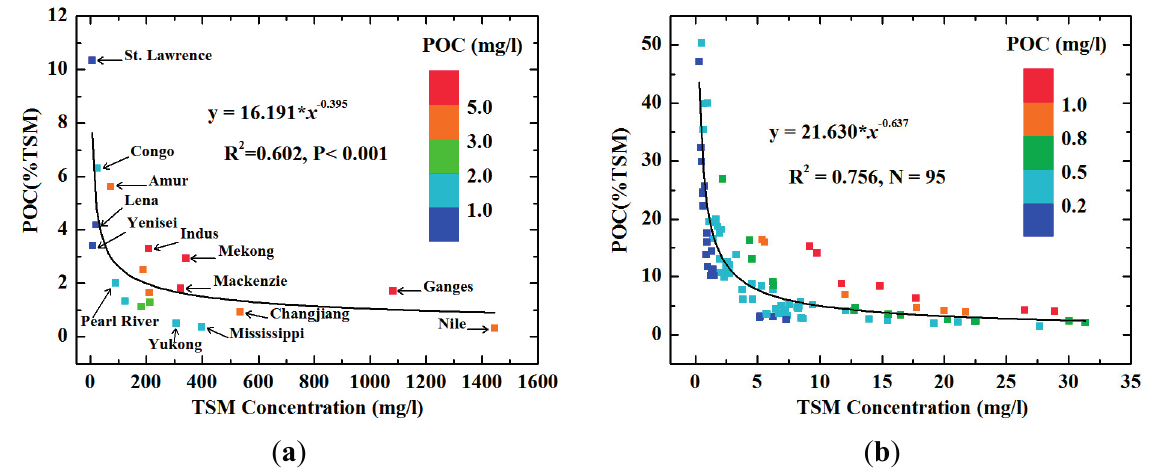
Figure 8. Correlation between POC(%TSM) and TSM concentration in: ( a ) 19 of the world’s major rivers (from Dagg et al. [35], Ni et al. [15], Ran et al. [33], and Coynel et al. [34]); and ( b ) the Pearl River Estuary (from our four seasonal